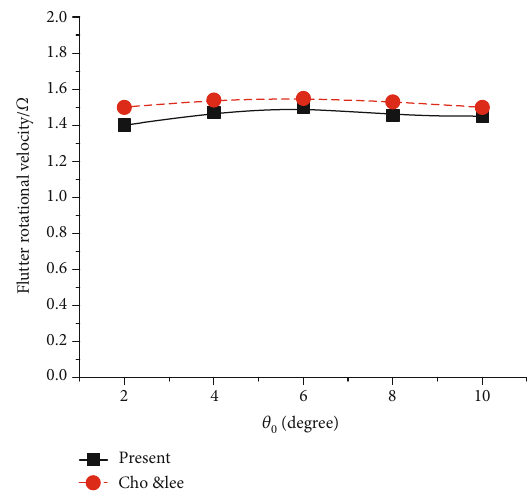
Figure 8: Flutter rotational velocities of the blade ( AR = 18 : 07 ).